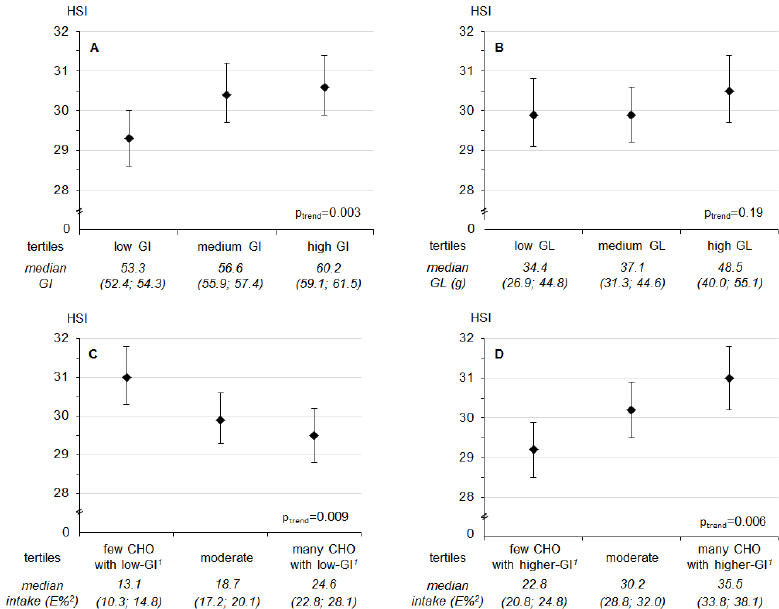
Figure 2. Predicted least square means (95% confidence interval) of hepatic steatosis index (HSI) by tertiles of ( A ) glycemic index (GI) after 6 p.m., ( B ) glycemic load (GL) after 6 p.m., ( C ) intake of low ‐ GI ‐ CHO 1 after 6 p.m. and ( D ) intake of higher ‐ GI ‐ CHO 1 after 6 p.m. Values are least ‐ square means for tertiles obtained from linear regression models. p ‐ values are based on models using the continuous exposure variables. Models were adjusted for sex, age at blood withdrawal, gestational weight gain, duration of pregnancy and birth weight, maternal educational status ( ≥ 12 years of schooling yes/no), maternal overweight ( ≥ 25 kg/m 2 yes/no), baseline BMI ‐ SDS, and baseline evening intake of saturated fatty acids ( N = 253). Values below the figure refer to median intakes (25th; 75th percentiles) in each tertile of the respective exposure. 1 Distinction between carbohydrate intake from low ‐ and higher ‐ GI food sources with a GI of 55 as cut ‐ off; 2 % of energy intake after 6 p.m.